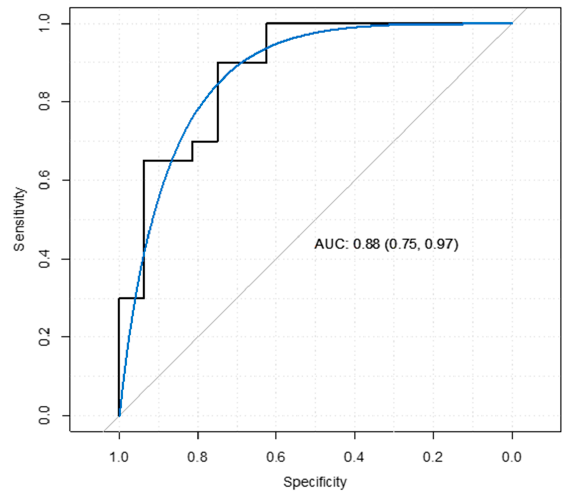
Hosmer and Lemeshow test: Chi-square = 11.51; df = 8; p = 0.2 * indicates statistical significance.